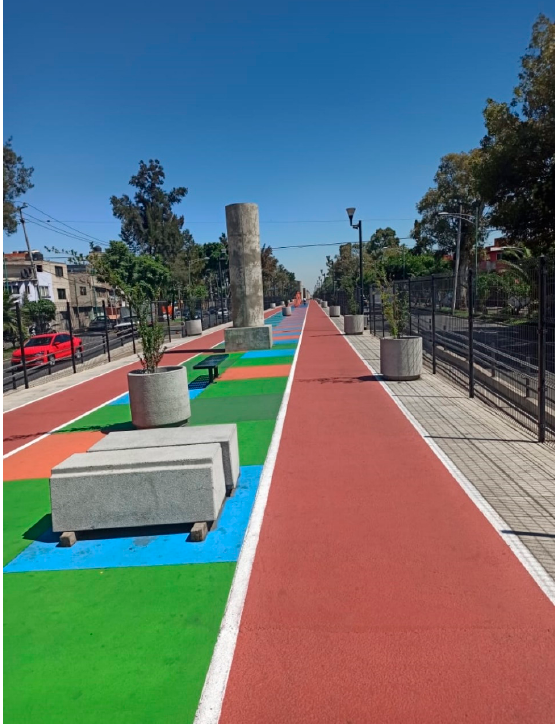
Figure 6. A space identified as a ‘park’ by Participant 11 (Iztacalco).